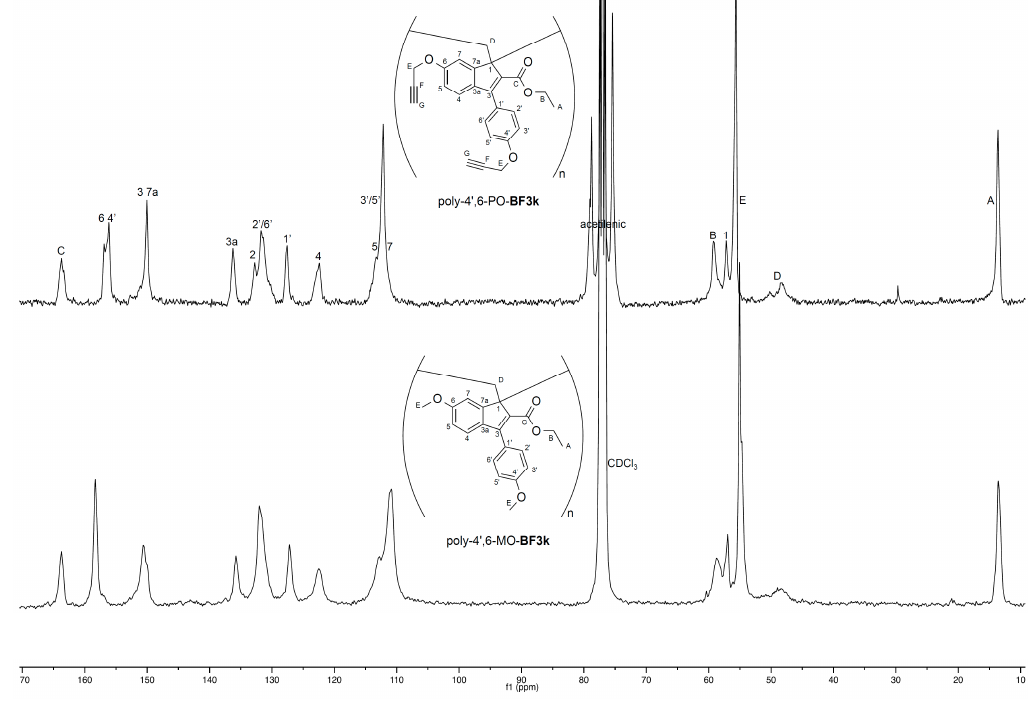
Figure 9. 13 C NMR spectrum (CDCl 3 ) of poly-4’,6-PO- BF3k ( top trace ) compared with that of previously reported poly-4’6-MO- BF3k ( bottom trace ).